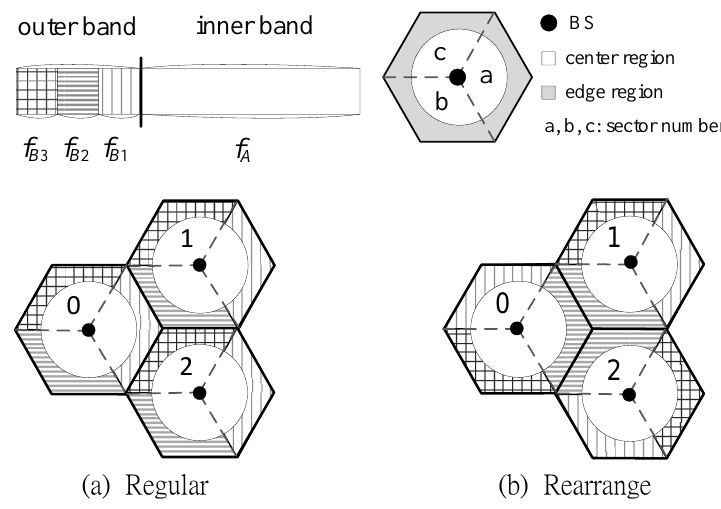
Figure 1. Regular and rearranged frequency planning for a tri-sector cellular